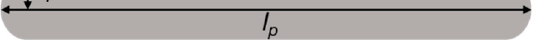
Figure 1. Schematic description of β ”-Mg 5 S 6 phase. The precipitates are assumed to grow at the needle tip and their length changes based on the aspect ratio.